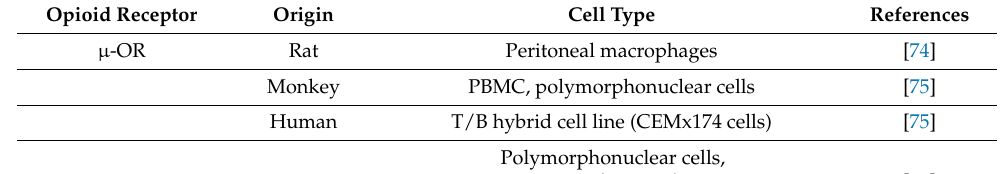
Table 1. Expression of OR in immune cell-derived cell lines and in untreated immune cells isolated from animals and